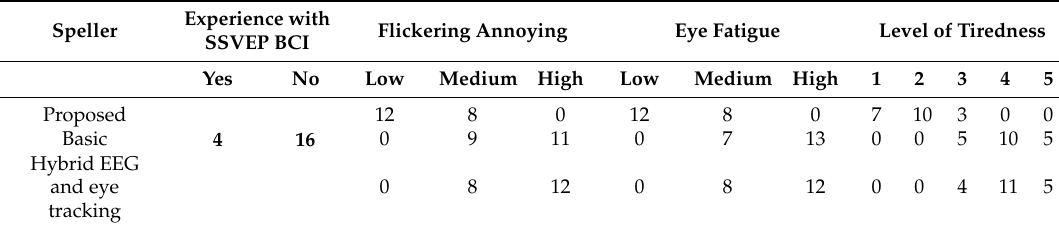
Table 1. Results from the